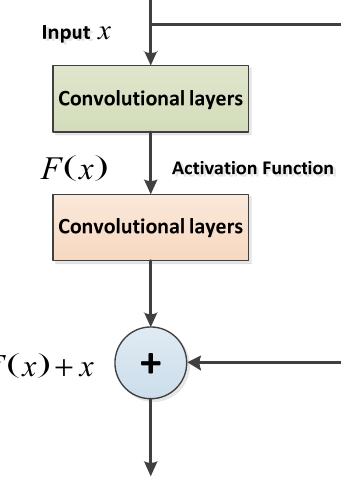
Figure 5. The structure of the residual unit.